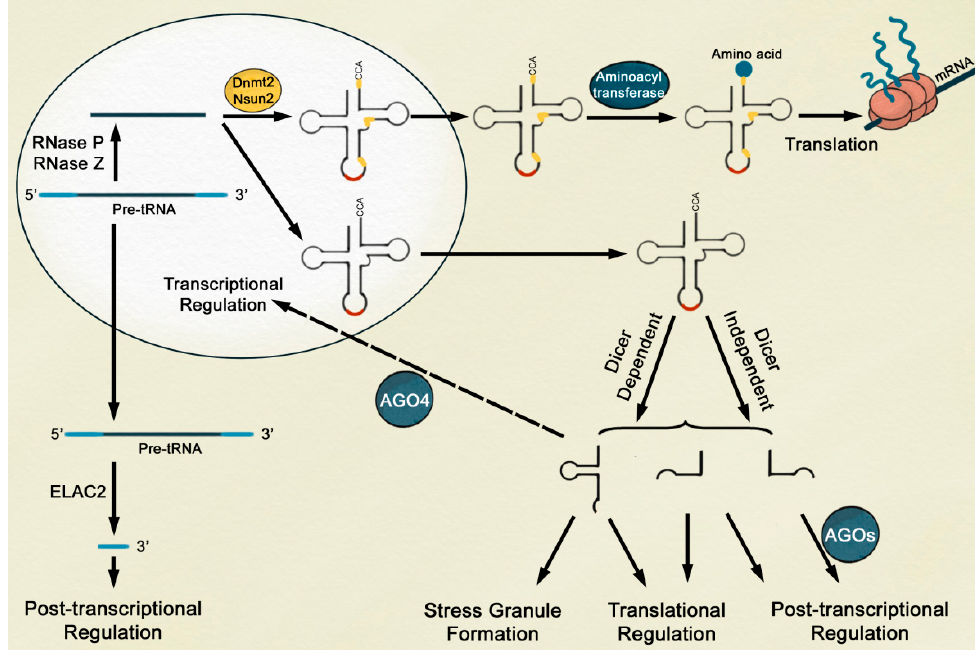
Figure 3. A proposed model on the diverse function of tRFs in gene expression during stress responses. Whereas mature tRNAs methylated by Dnmt2 (DNA methyltransferase 2) and Nsun2 (NOP2/Sun RNA methyltransferase family member 2) (yellow mark) participate in translation, unmethylated mature tRNAs or pre-tRNAs are processed into various types of tRFs [9,11,24,43]. Production of tRFs is promoted by abiotic stress conditions to eventually control gene expression by transcriptional, post-transcriptional, and translational regulation.